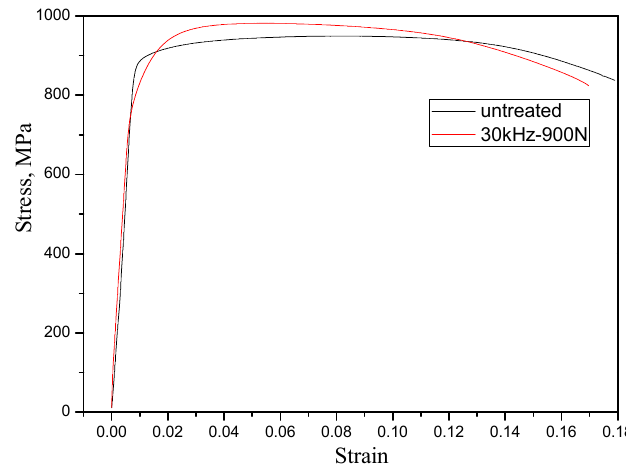
Figure 8. The stress strain curves for the MUSR-treated sample at 900 N and untreated sample.